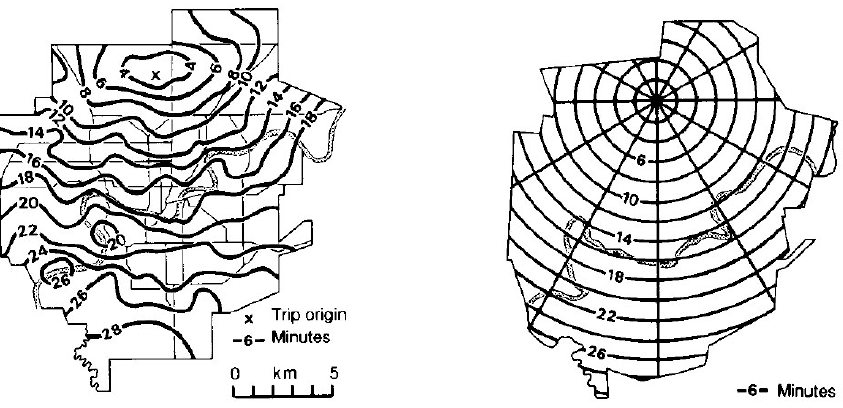
Figure 1. Irregular isochrones and concentric isochrones [11].